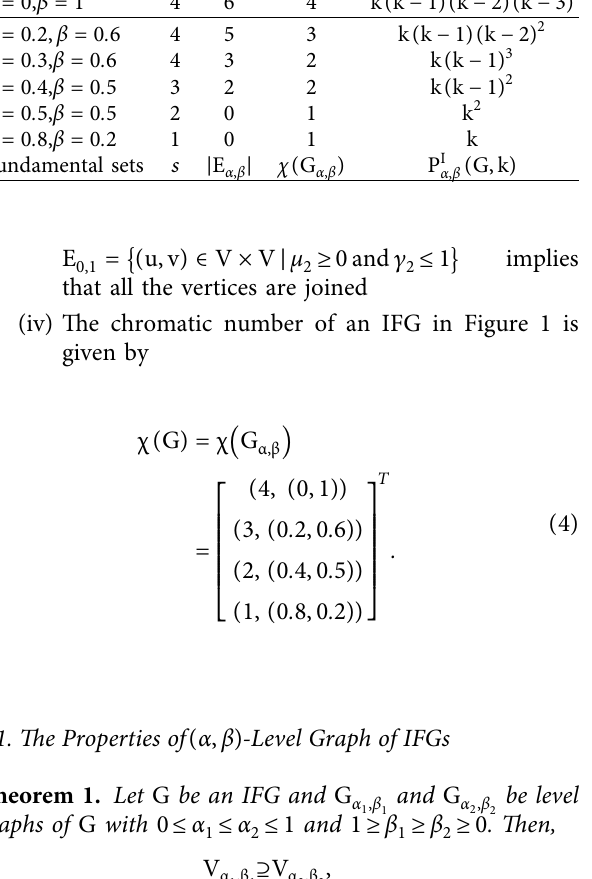
of the graph in Figure 1 along α , β